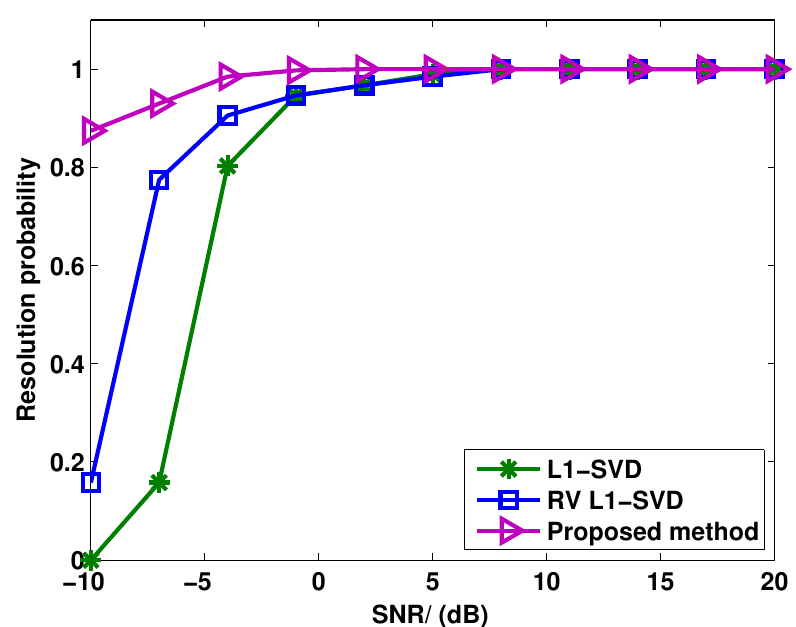
Figure 5. Target resolution probability of l uncorrelated targets when the SNR varies from − 10 dB to 20 dB.